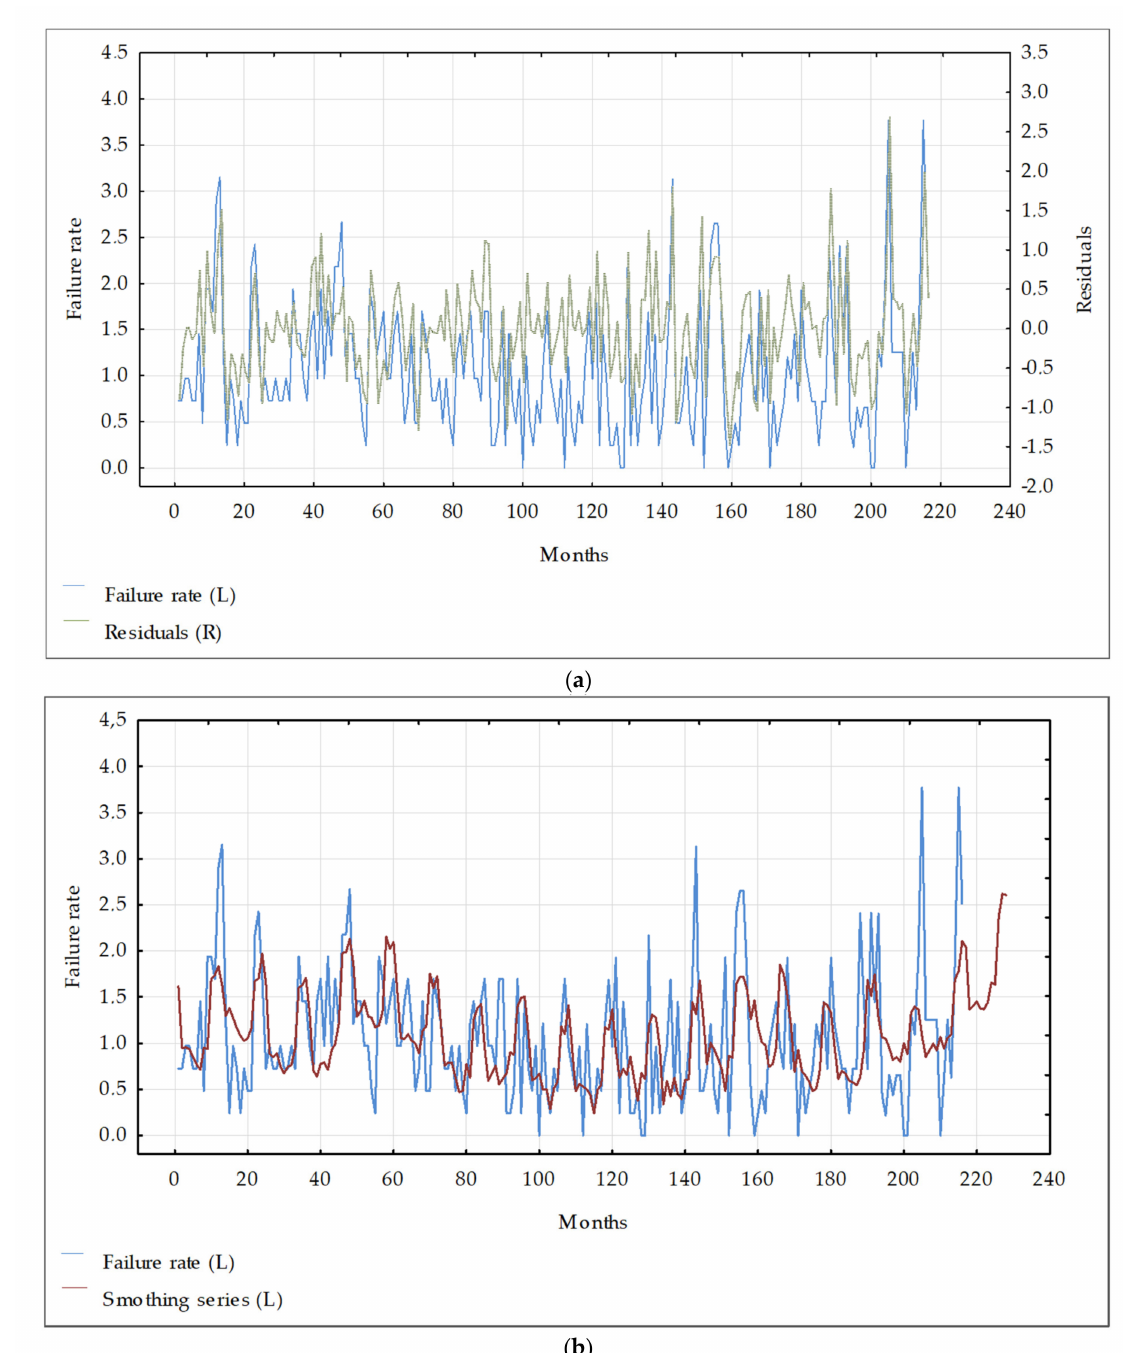
Figure 4. Predicted failures of mains by exponential smoothing, for additive seasonality during months for S 0 = 1.26, T 0 = 0.0017: ( a ) data vs. model comparison, ( b ) model